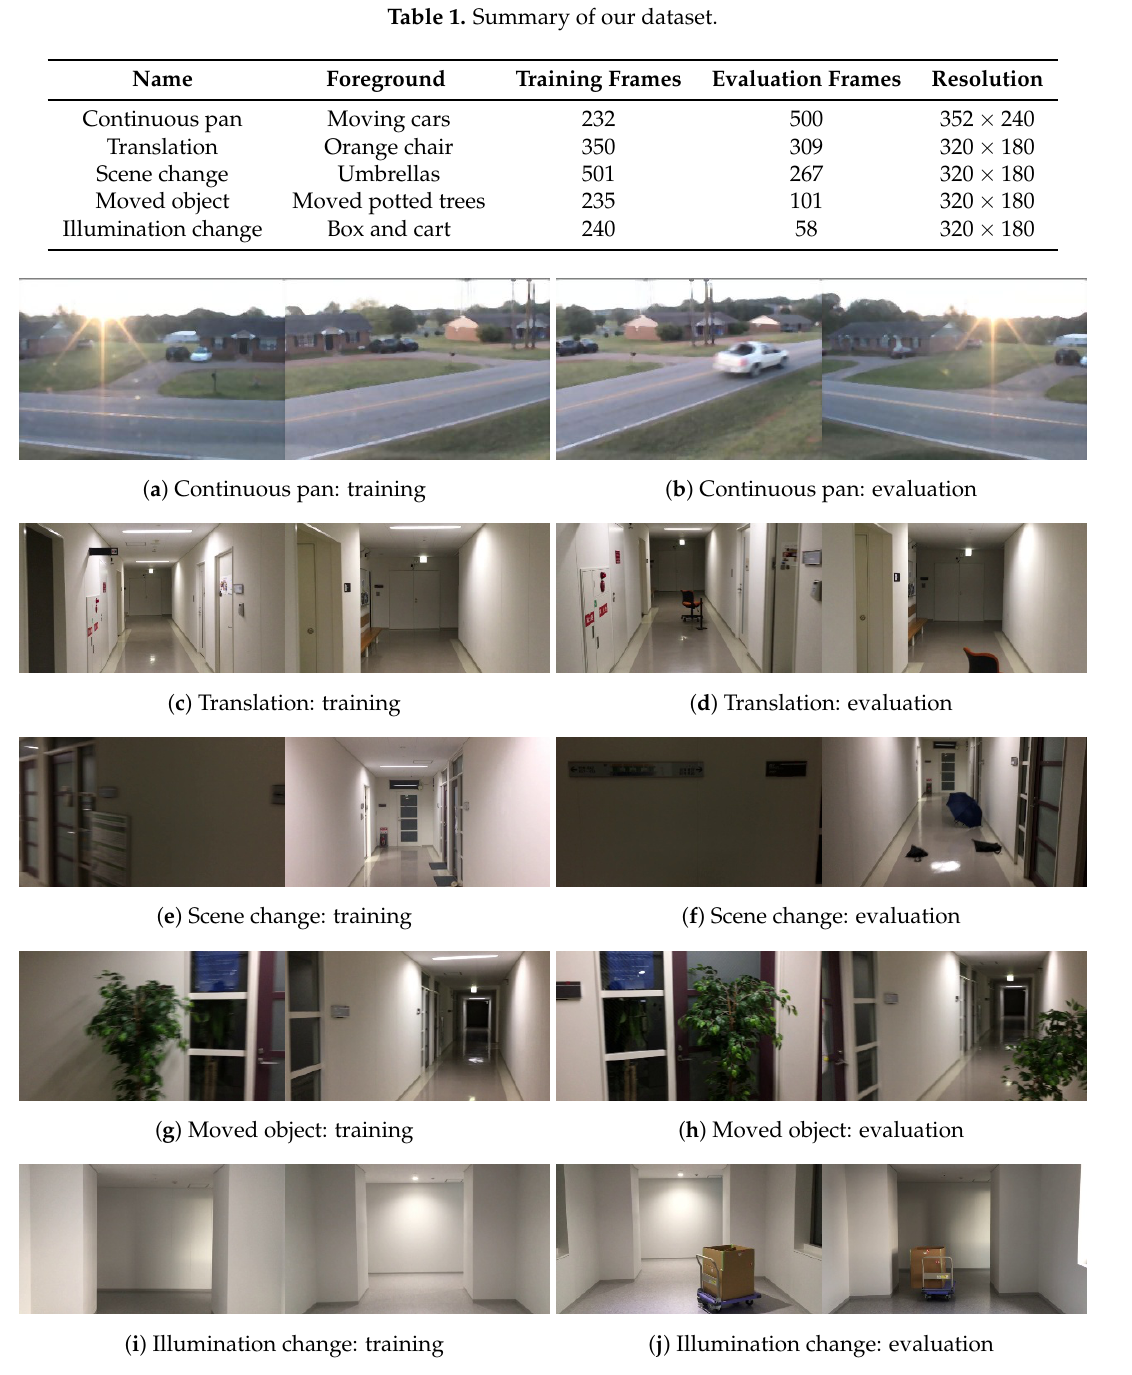
Figure 4. Example images from our